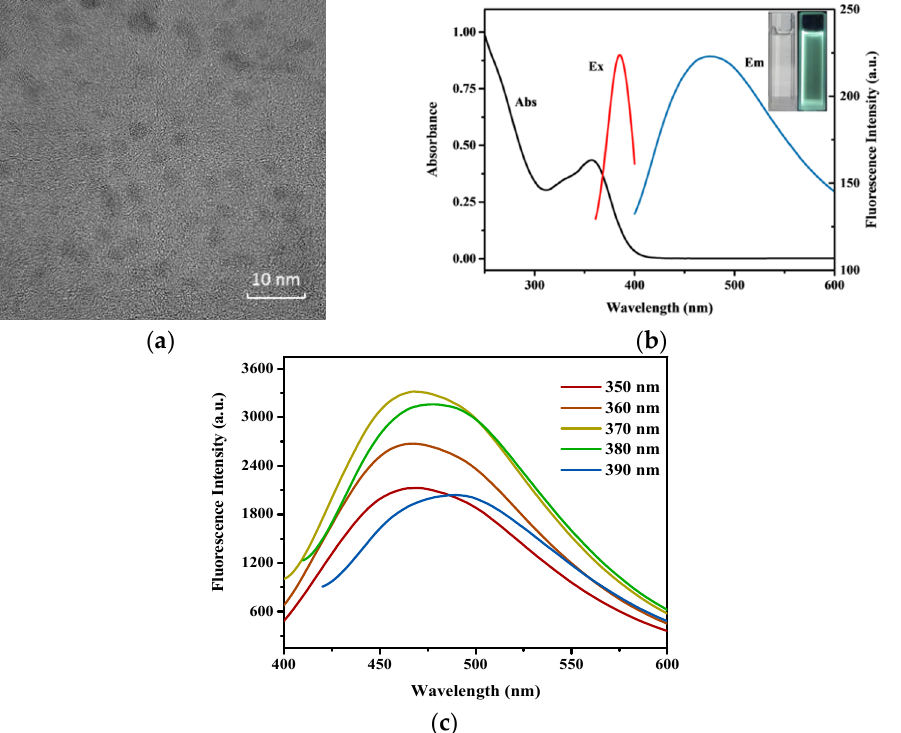
Figure 1. TEM image ( a ), UV-Vis absorption and the optimal excitation and emission wavelengths ( b ) and the excitation-dependent fluorescence spectra from 350 nm to 390 nm ( c ) of PEI-CdS QDs. The PEI-CdS QD-embedded photonic crystal hydrogel was fabricated via a two-step procedure (Scheme 1). First, the photonic crystal template was constructed on the surface of a slide via the vertical deposition self-assembly of polystyrene microspheres. Then, the precursor solution containing AMD, BIS, AIBA, and PEI-CdS QDs filled in the gaps of the photonic crystal template, which was heated at 60 °C for 5 h to promote polymer for- mation. After these processes, the obtained hydrogel film was carefully removed from the slide.